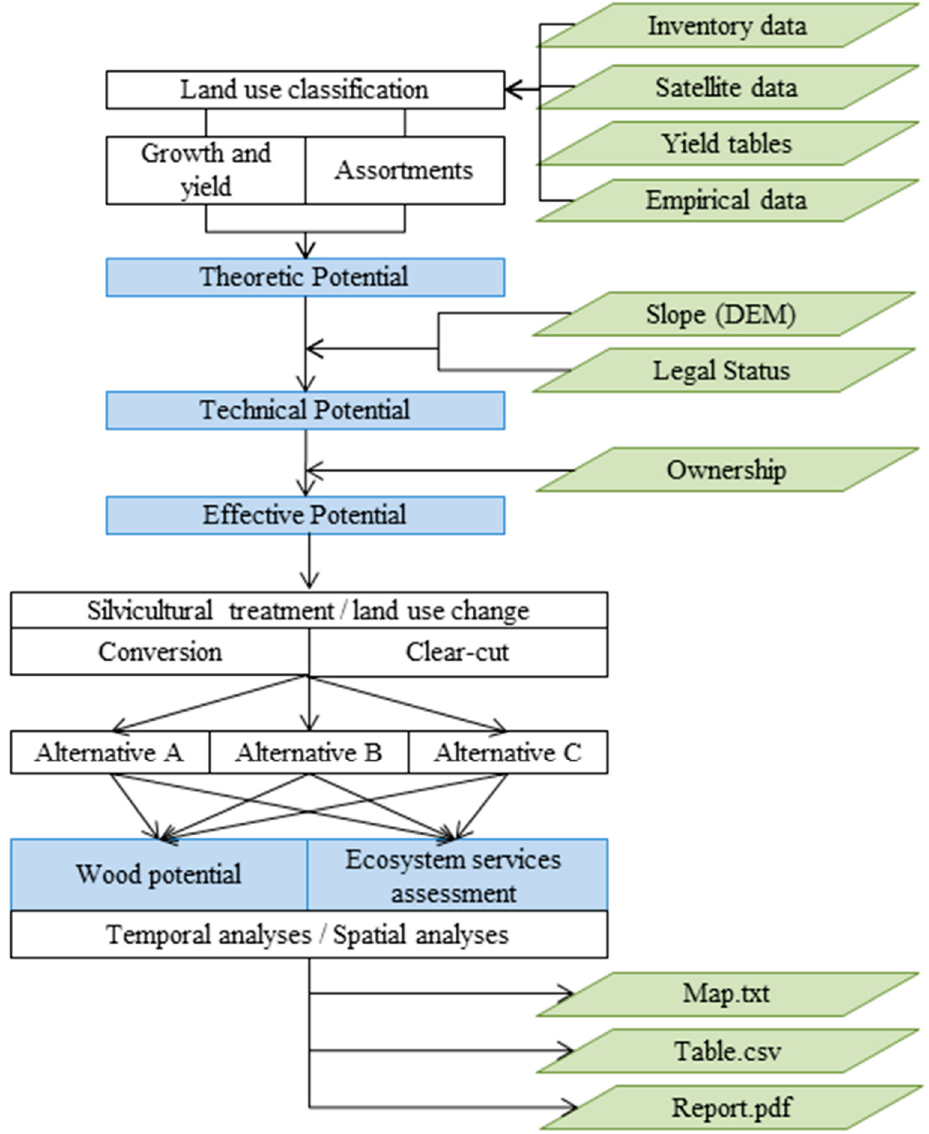
Figure 5. Flow chart of methods and data that were used to simulate management alternatives in the planning region “Upper Elbe Valley/Eastern Ore Mts.”. Green parallelograms represent data; blue squares are (intermediate) outputs, which are used for supporting